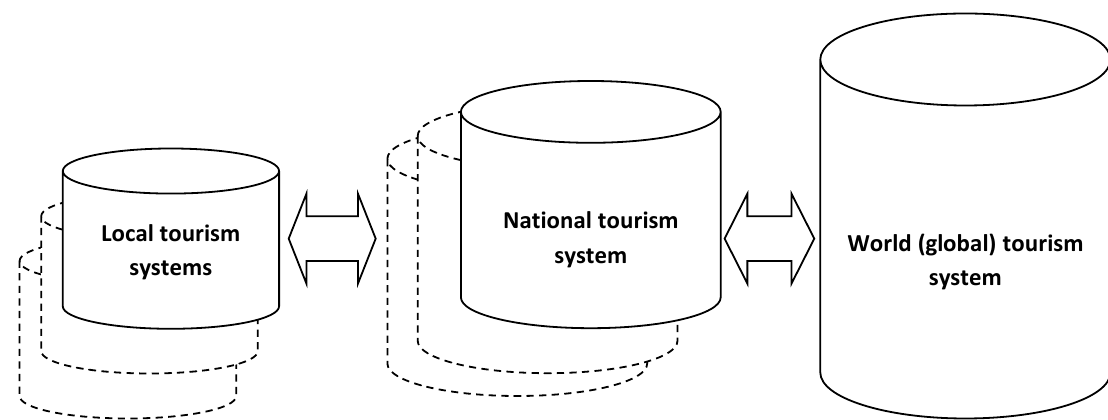
Figure 4. The hierarchy of the levels of tourism